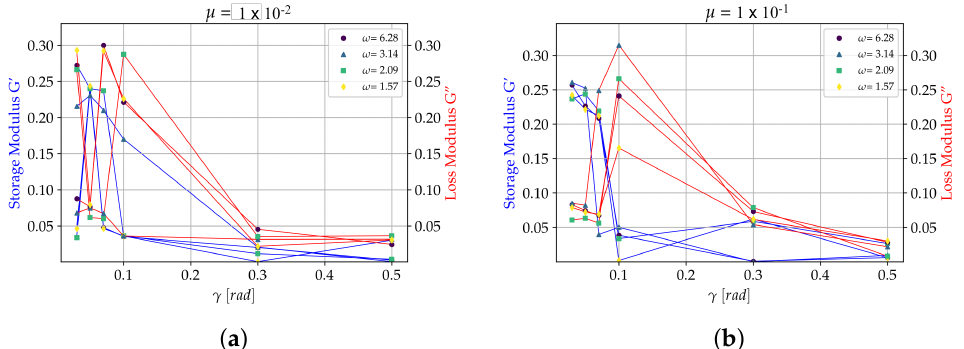
Figure 19. Storage and Loss moduli obtained for a combined viscoelastic configuration accord- ing to proposed model. Blue: Storage modulus G (cid:48) , red: Loss modulus G (cid:48)(cid:48) . Tests obtained for 3 × 10 − 2 ≤ γ ≤ 0.5, and for oscillating frequencies ω = 1.57, 2.09, 3.14, 6.28 rad s − 1 . ( a ) Results for µ = 1 × 10 − 2 . ( b ) Results for µ = 1 × 10 − 1